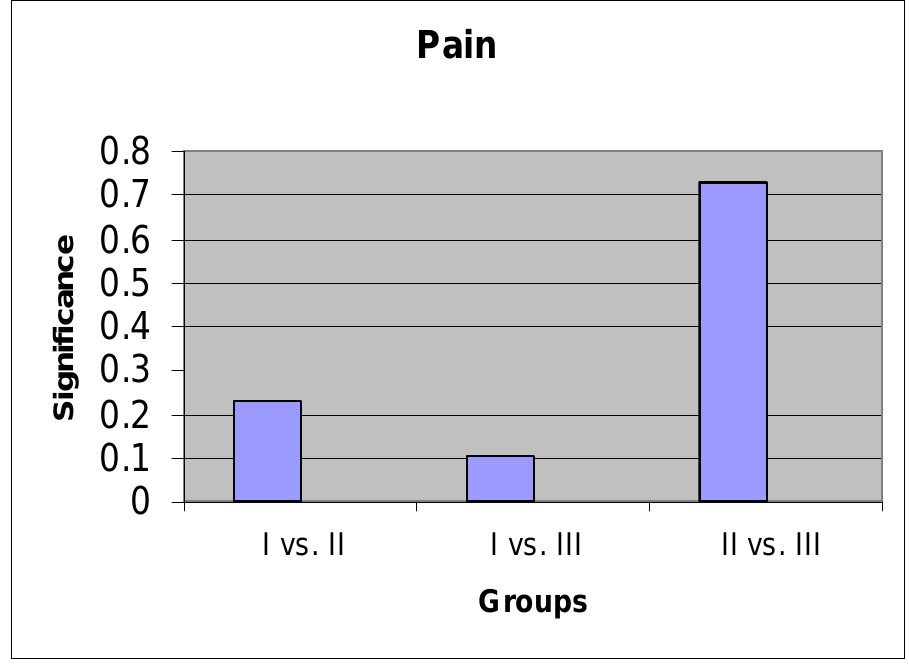
FIGURE 3. Pain variation between groups.